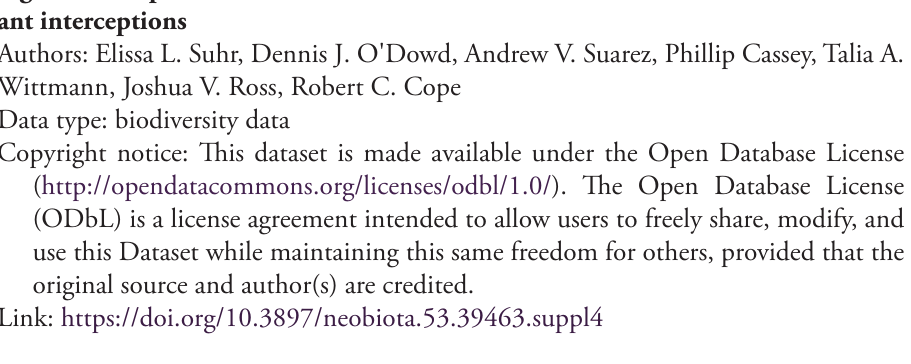
Figure S3. Import value over time for the 4 commodities with the most associated ant